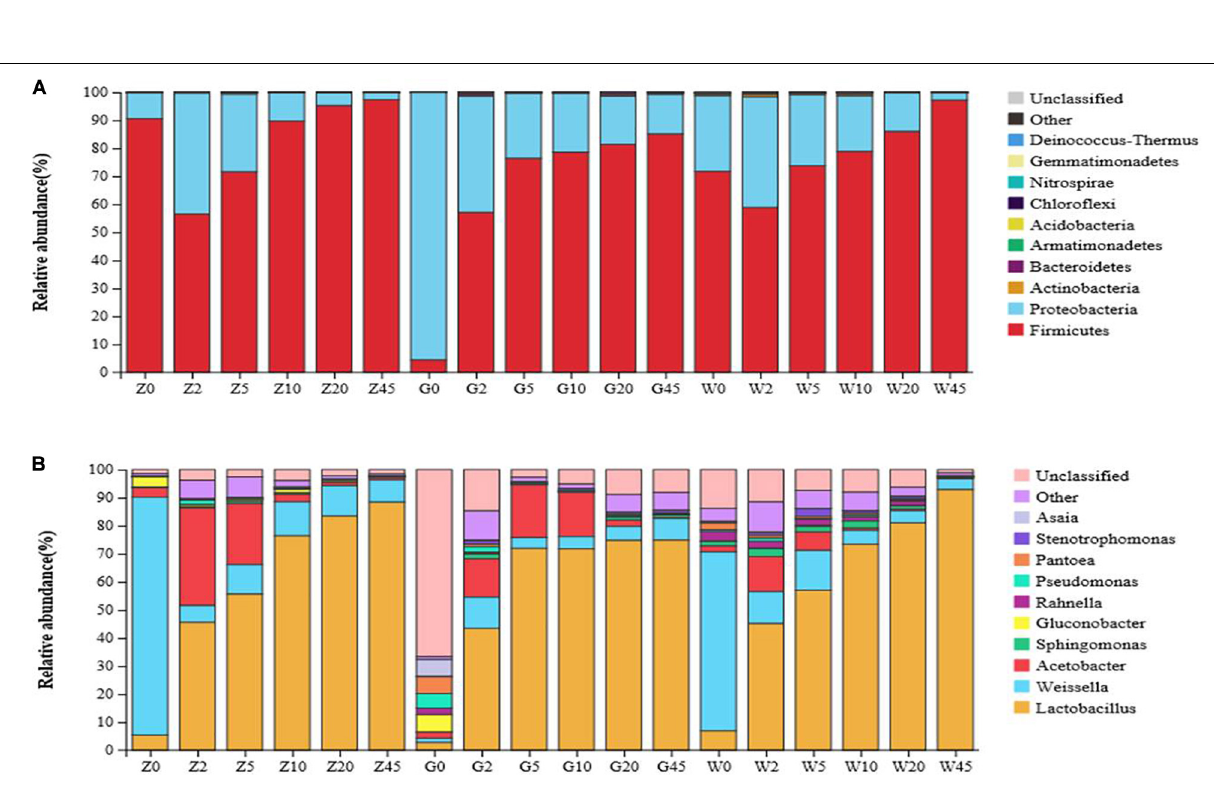
Frontiers in Microbiology |